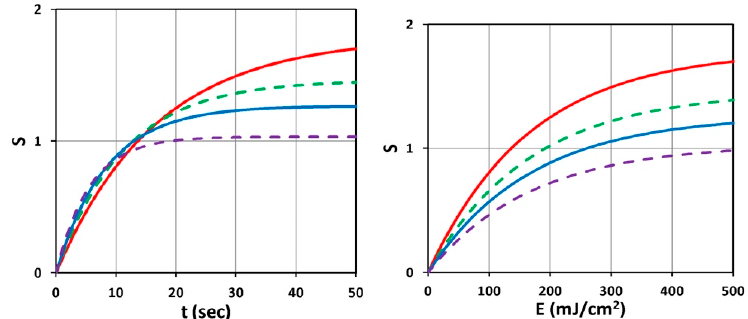
Figure 3. Time profiles of S versus t ( left figure ) and versus dose E 0 ( right figure ) for various light intensity I 0 = (10, 15, 20, 30) mW/cm 2 , shown by (red, blue, green, purple) curves, for D = 1.0 cm, C 0 = 3 mM, at z = 0.5 cm.